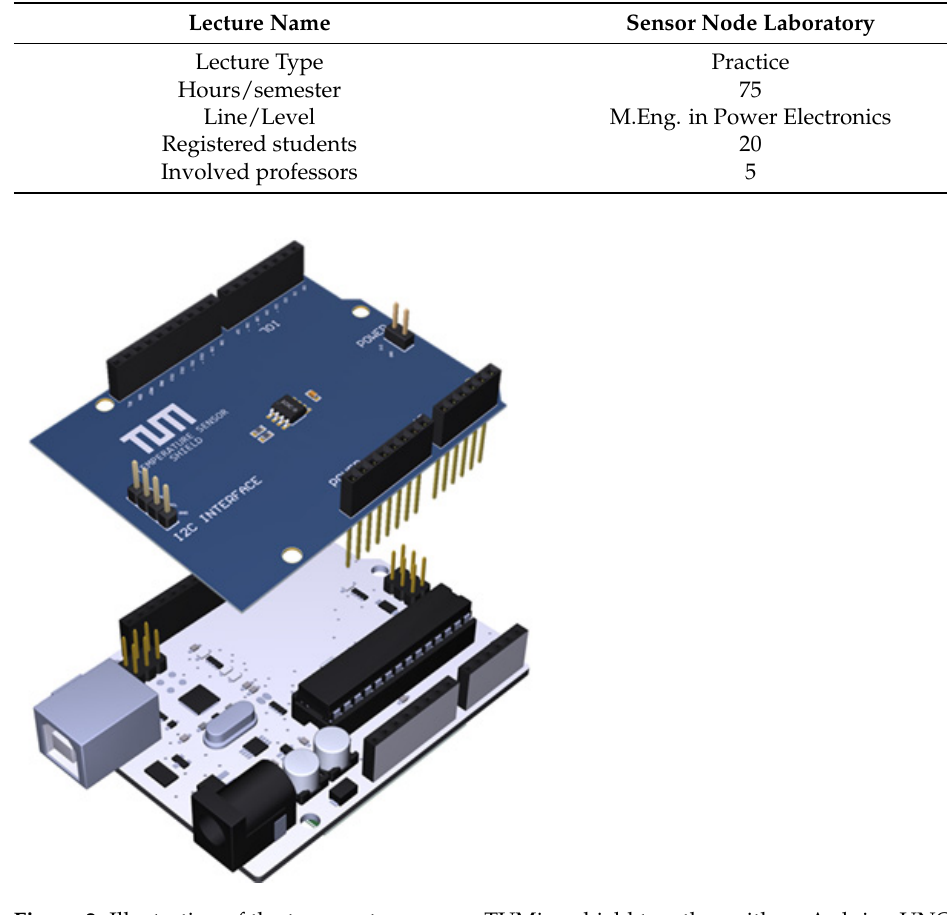
Figure 2. Illustration of the temperature sensor TUMino shield together with an Arduino UNO.